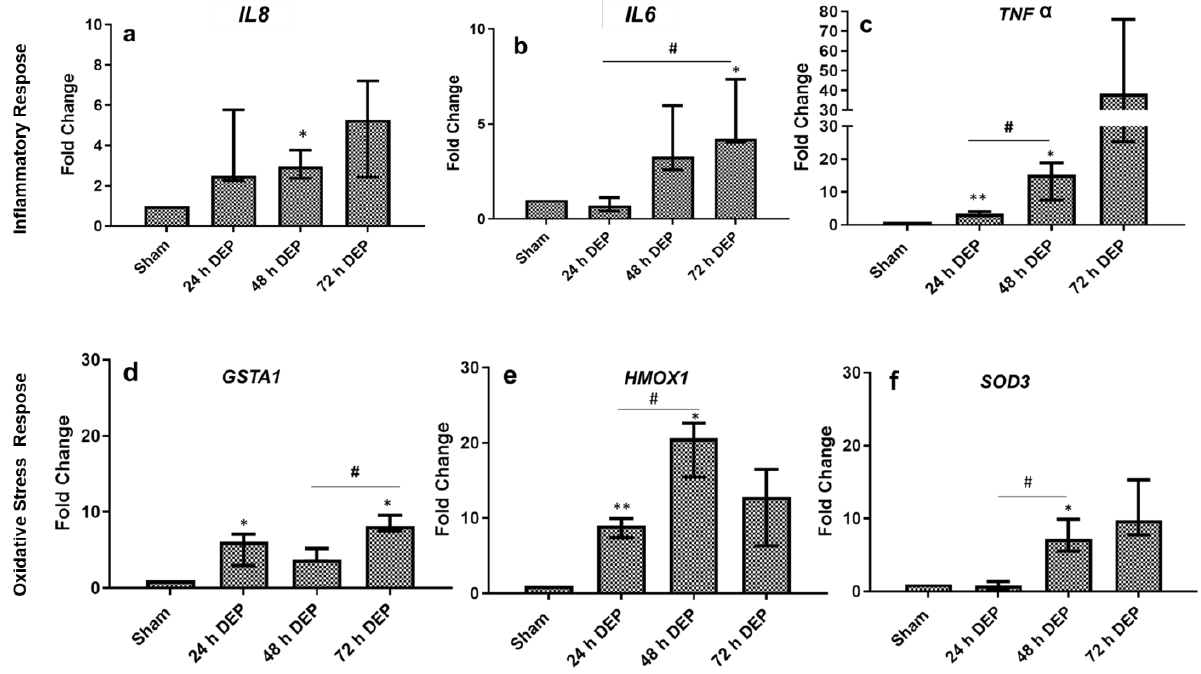
Figure 4. mRNA expression of inflammatory and oxidative stress markers following repeated exposure to diesel exhaust particles (DEP:12.7 µ g/cm 2 ). Fold change in inflammatory (IL8, IL6, and TNFα ( a – c )) and oxidative stress ( GSTA1, HMOX1, and SOD3 ( d – f )) responses in bronchial mucosa models developed at the air–liquid interface (bro-ALI) following incubation for 24 hours (h) after 3 min exposure to sham (control: clean air exposure) and DEP for 3 time points (24, 48 and 72 h). Data presented as median and 25th–75th percentiles, fold change = 2- ∆ Ct of models / 2- ∆ Ct of sham-exposed bro-ALI (N = 3 donors and n = 2 replicates/donor). p < 0.05/0.01 */**: